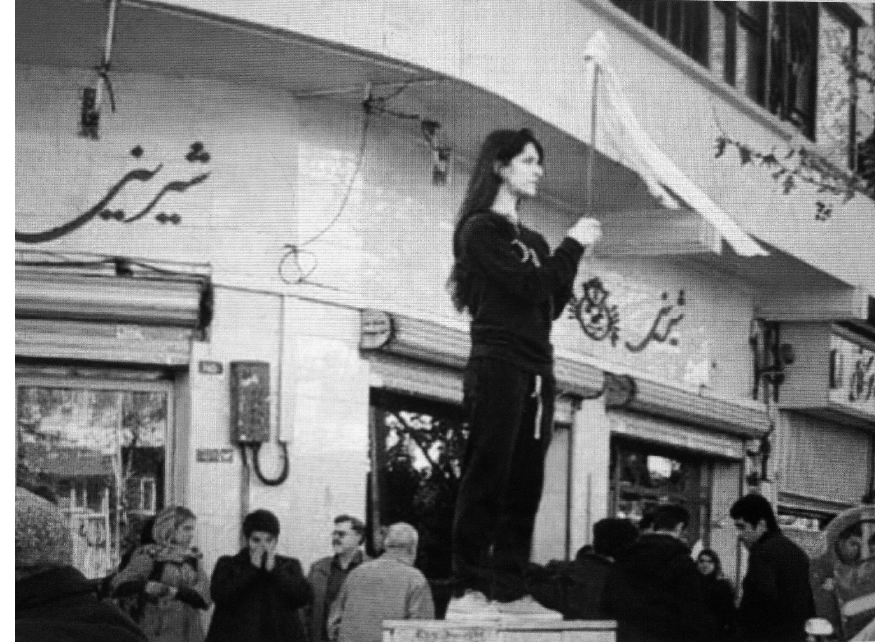
Figure 9. Vida Movahed, 31, known as Dokhtar e Khiyaban e Enghelab / The Girl from the Enghelab Street was arrested for her act of protest against the compulsory hijab removing her white scarf and waving it on a stick (#WhiteWednesdays) Women in Iran are waving white clothes on the end of sticks—but it is an act of defiance, not surrender. Source: https://www.cbc.ca/radio/thecurrent/the-current-for-january-31-2018-1.4510938/iranian-women-risk-arrest-as-they-remove-their-veils-for-whitewednesdays-1.4510942.